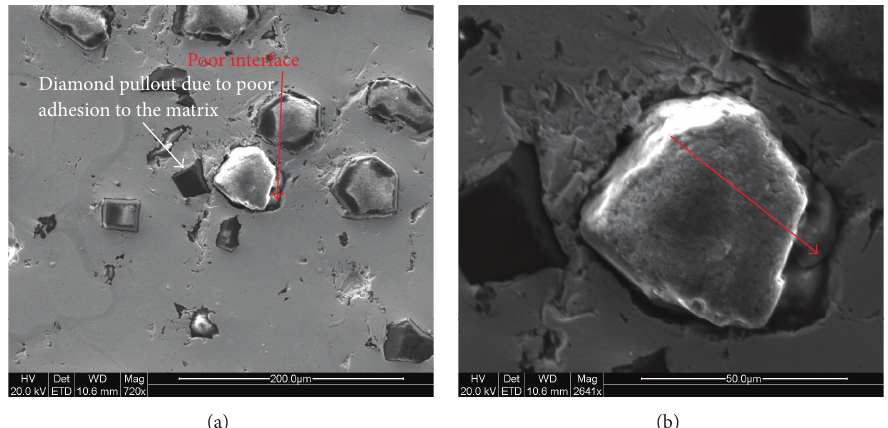
Figure 6: (a) Low and (b) high magnification SEM images clearly showing the poor interface that exists between the copper matrix and diamond particles.